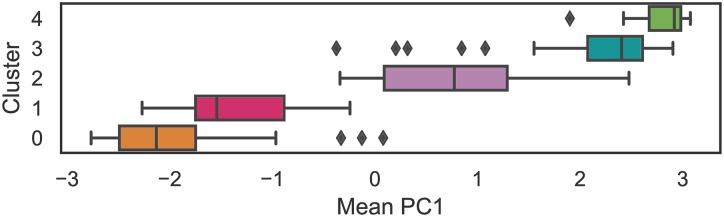
Distribution of Social Complexity (PC1) values for clustered polities.